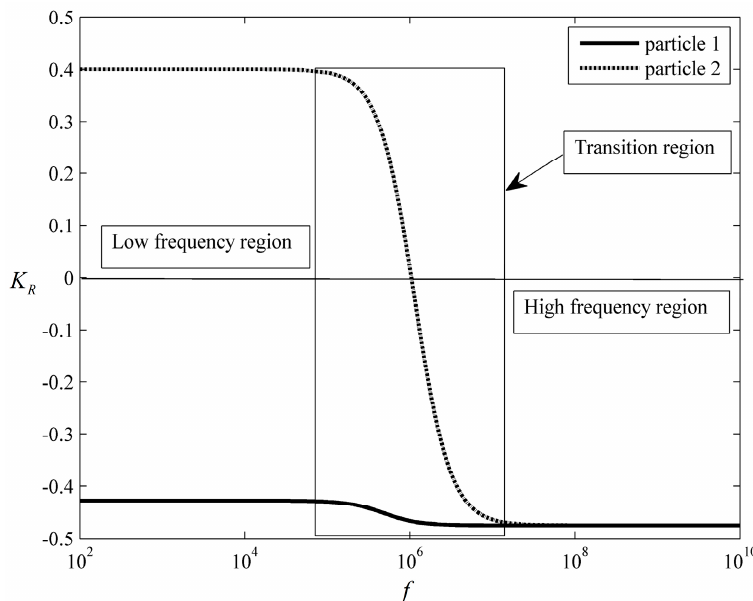
Figure 3. The real parts of the C–M factors of the two types of particles as a function of the frequency. In the low-frequency region, particle 1 is an nDEP particle, while particle 2 is a pDEP particle. In the transition region, particle 2 is transformed from a pDEP particle into an nDEP particle. In the high-frequency region, both particles are nDEP particles.